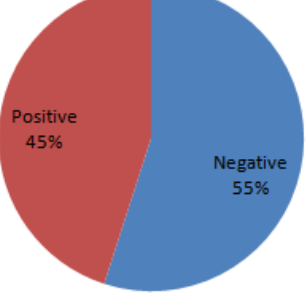
Figure 1. Principle of integration (n = 131).